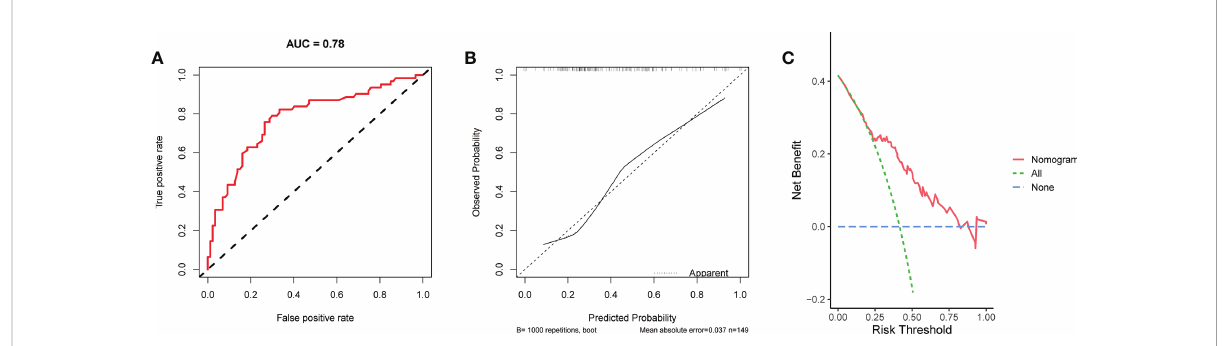
FIGURE 7 The ROC curve (A) , calibration curve (B) , and DCA curve (C) of the nomogram in the external validation